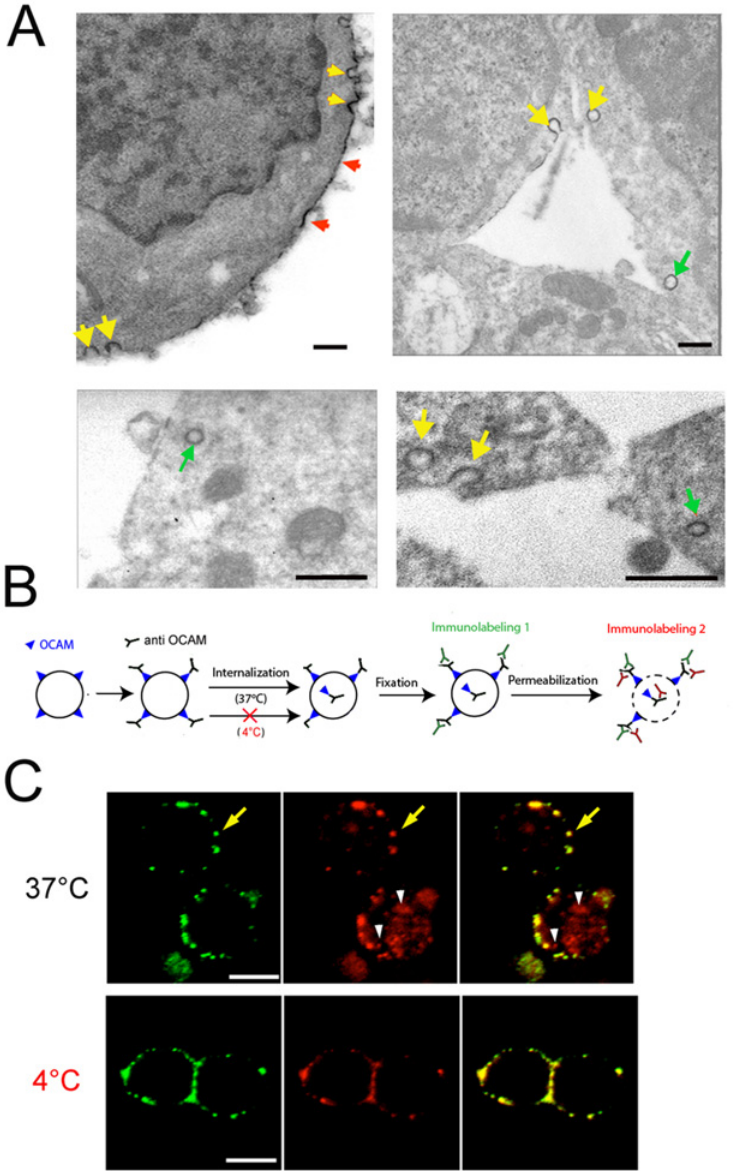
Fig 2. OCAM subcellular localization and internalization. ( A ): Electron microscopy of OCAM. Microphotographs of peroxydase-immunodetected OCAM shows its association with the cytoplasmic membrane (red arrows), with the membrane undergoing endo- or exocytosis processes (omega-like structures, yellow arrows) and with intracellular vesicles (green arrows). Scale bars = 0.5 μ m. (B) : Schematic of the internalization assay. ( C ): OCAM membrane staining (yellow arrows) is observed in both conditions (37°C, upper panels and 4°C, lower panels). Intracellular labelling of OCAM (white arrowheads), revealed by membrane permeabilization, is only observed when cells are incubated at 37°C with the OCAM antibody. Scale bars = 10 μ